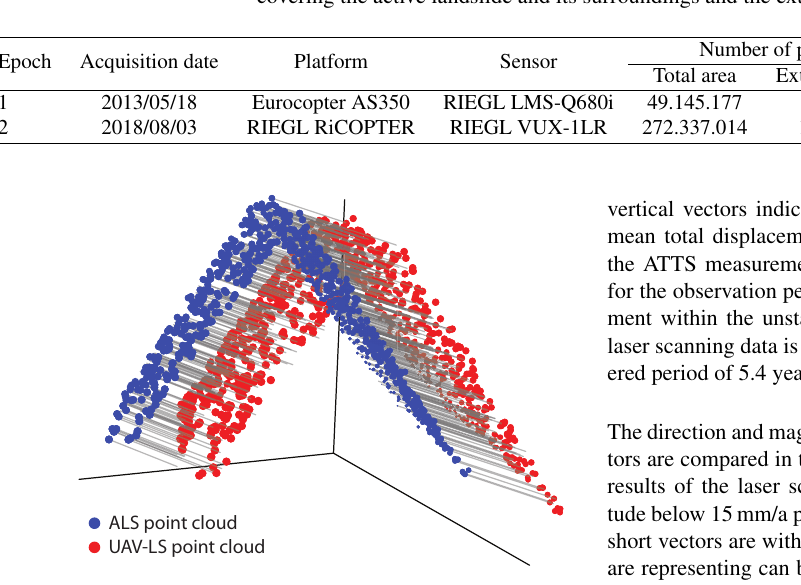
Table 1. Meta data for the used ALS and ULS data including the number of points and mean point density for the considered total area covering the active landslide and its surroundings and the extracted roofs.